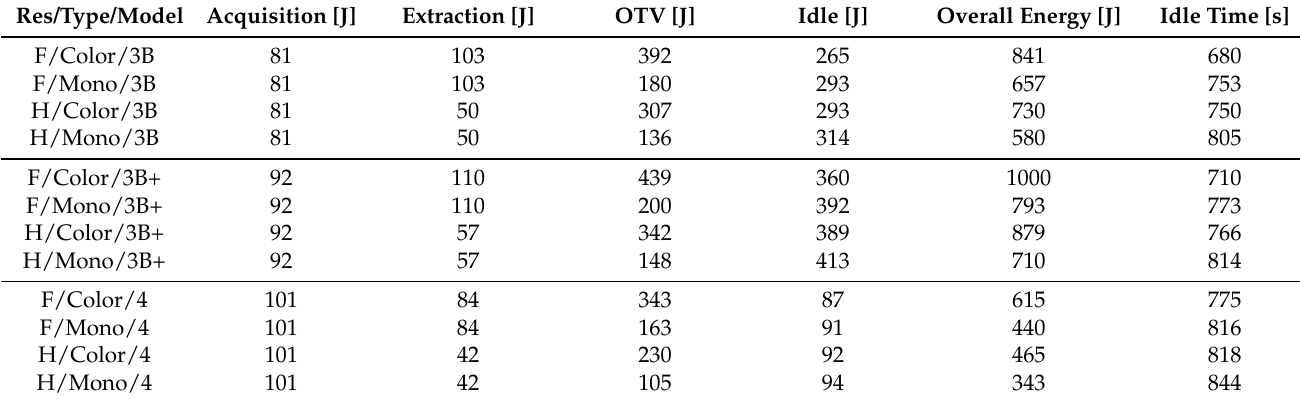
Table 1. Energy consumed by the three devices, configured to take advantage of SIMD and Multicore processing capabilities, during each phase of a 15-min measurement cycle. Additionally, the rightmost column reports the seconds of idle